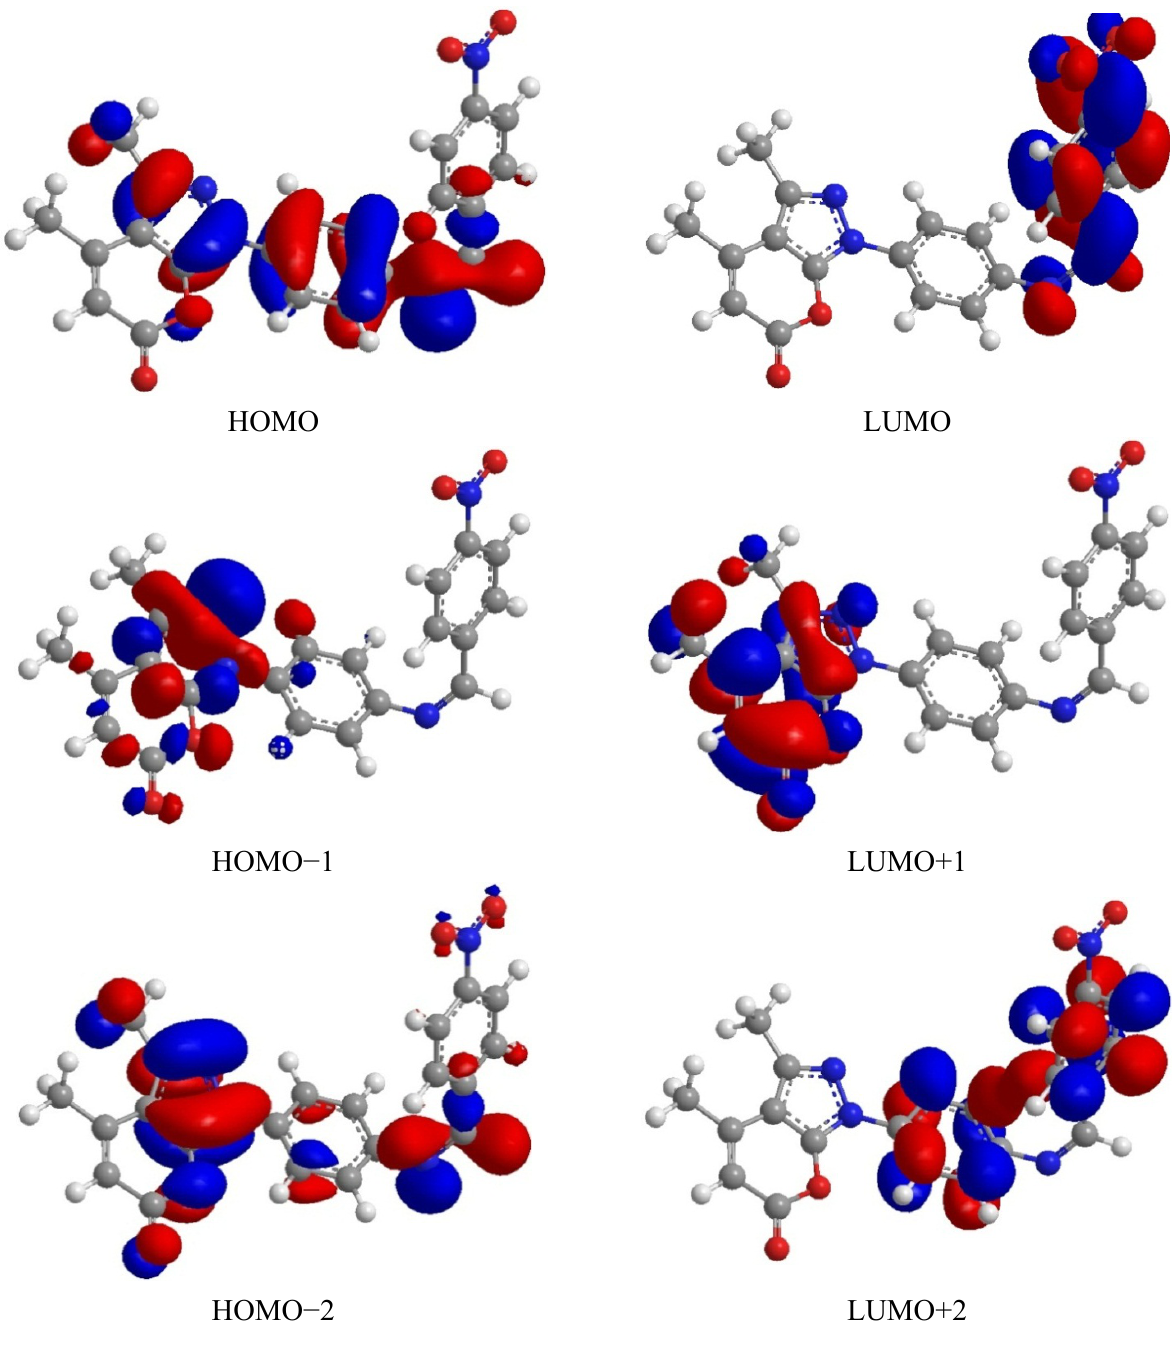
Figure 2. Highest occupied molecular orbital (HOMO) and the lowest unoccupied molecular orbital of compound 5